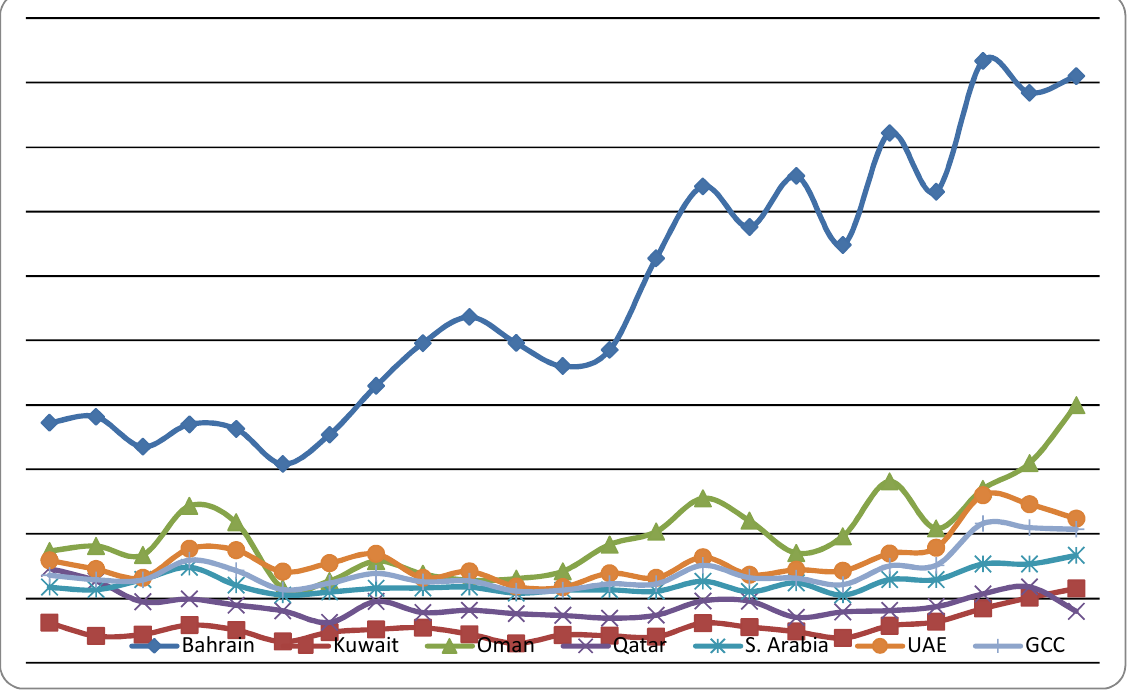
Fig. 1. The percentage of the export to GCCC from the total export